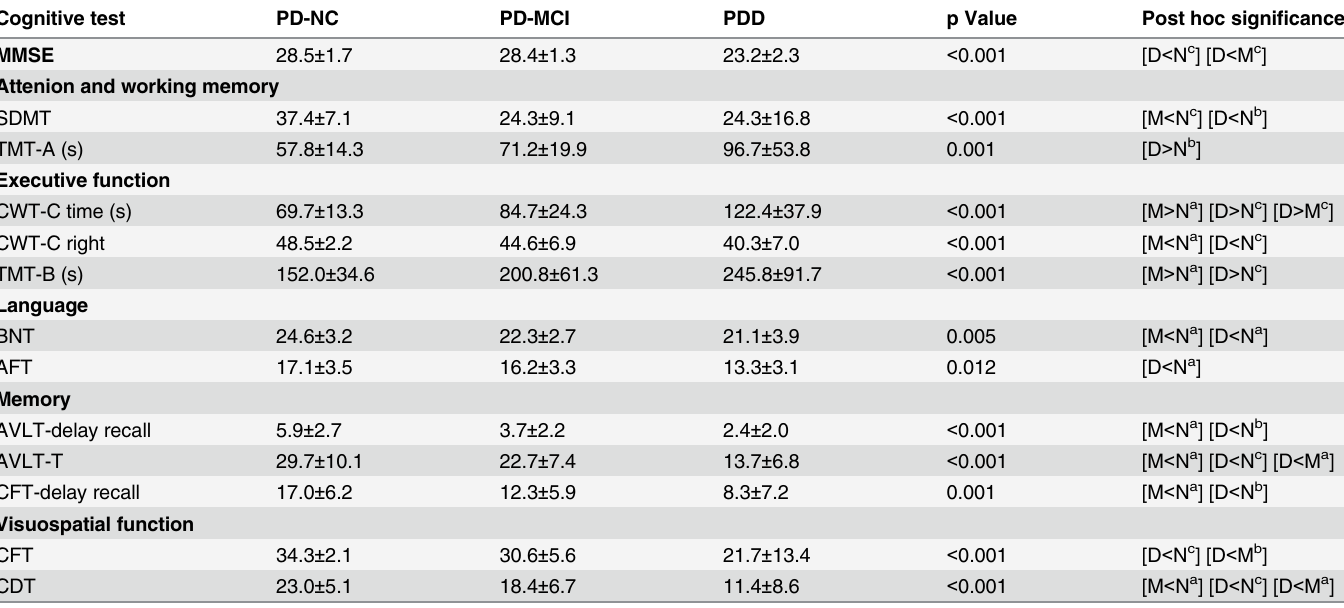
Table 2. Neuropsychological testing in Parkinson ’ s disease